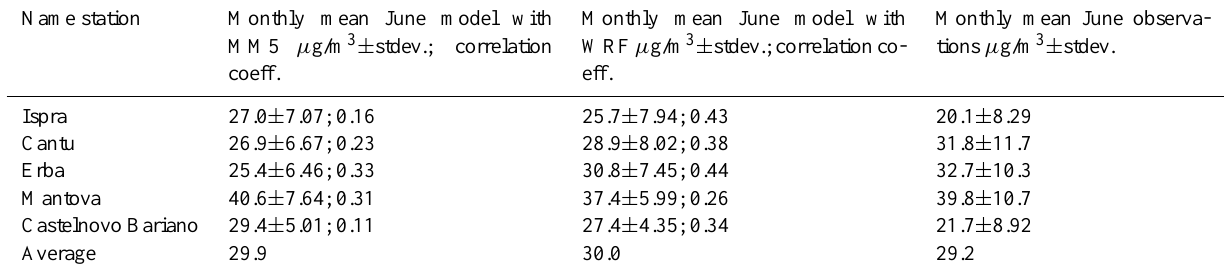
Table 6. Monthly mean PM 10 concentrations calculated by the CHIMERE model using MM5 and WRF meteorology for June 2005, including the standard deviation and the temporal correlation coefficient, together with the measurements.